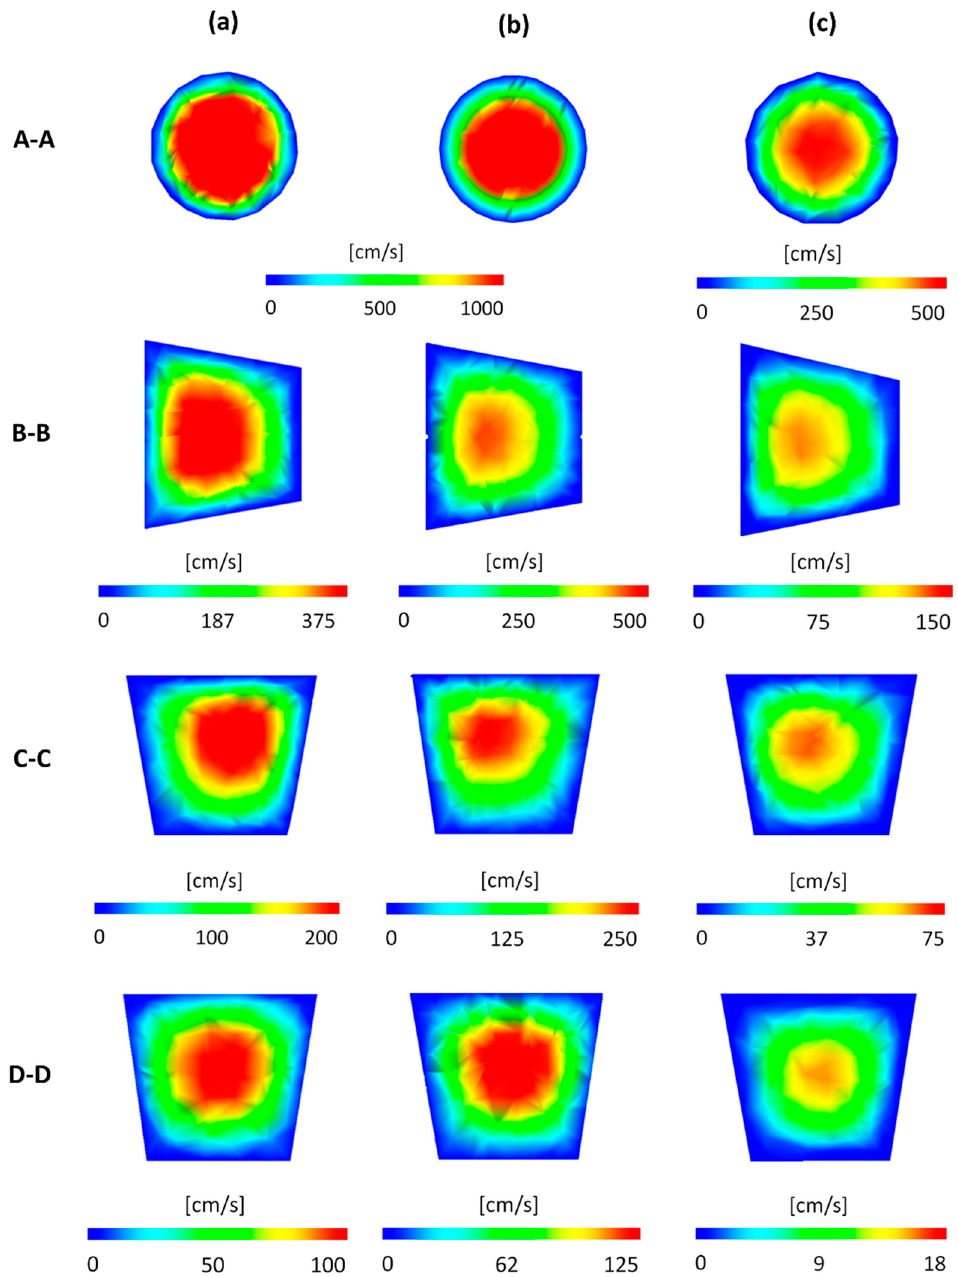
Figure 15. Velocity plots in specific cross-sections of the runner system obtained from simulations performed on different data, and using STASA optimization procedures: ( a ) maximum positive imbalance ( GS ), ( b ) maximum negative imbalance ( G 2), ( c ) optimum STASA (G 1 ) . The optimized data obtained by simulation have been compared with the experimental values, and the relative errors have been listed in Figure 16. This comparison is limited to the RSM method and BCM procedure since the Taguchi method has some parameter limitations (see Section 4.2).